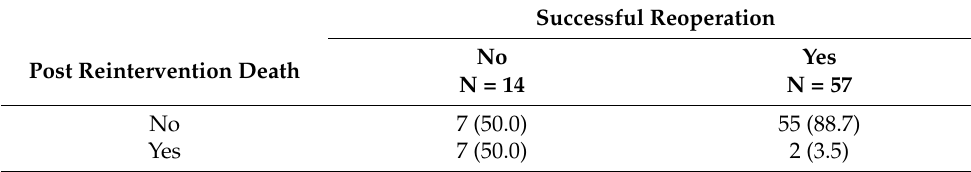
Statistics are: N (column %); p < 0.001.